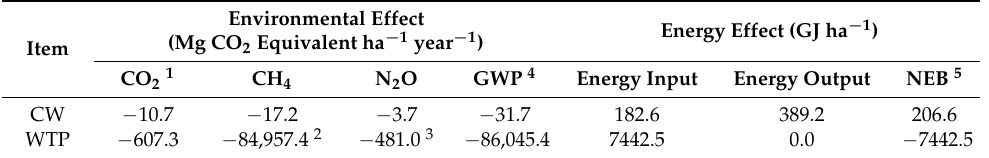
Table 3. Net energy balance, net GHG reduction for the CW and wastewater treatment plant (WTP) (positive values means sequestration, negative values indicates release).